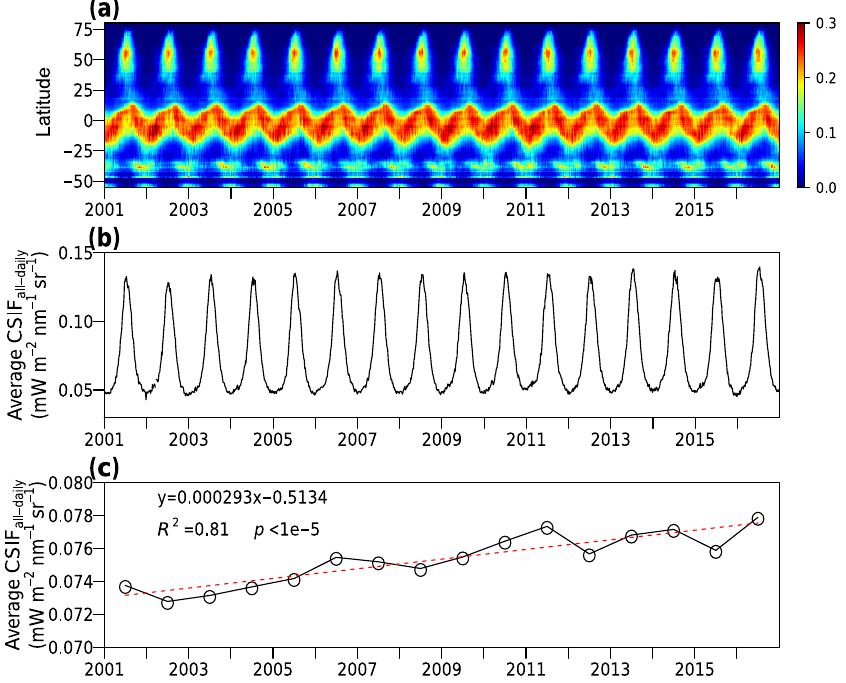
Figure 7. Seasonal and interannual variation of all-sky condition daily CSIF (CSIF all-daily ). (a) The latitudinal averages of CSIF all-daily for each 4-day period (in mWm − 2 nm − 1 sr − 1 ). (b) Global average of CSIF all-daily for each 4-day period. (c) The annual average CSIF all-daily between 2001 and 2016 (black line) with linear fit (red dashed